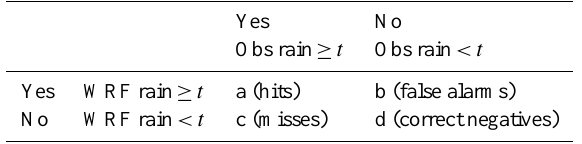
Table 3. Contingency table of counts for a binary type of